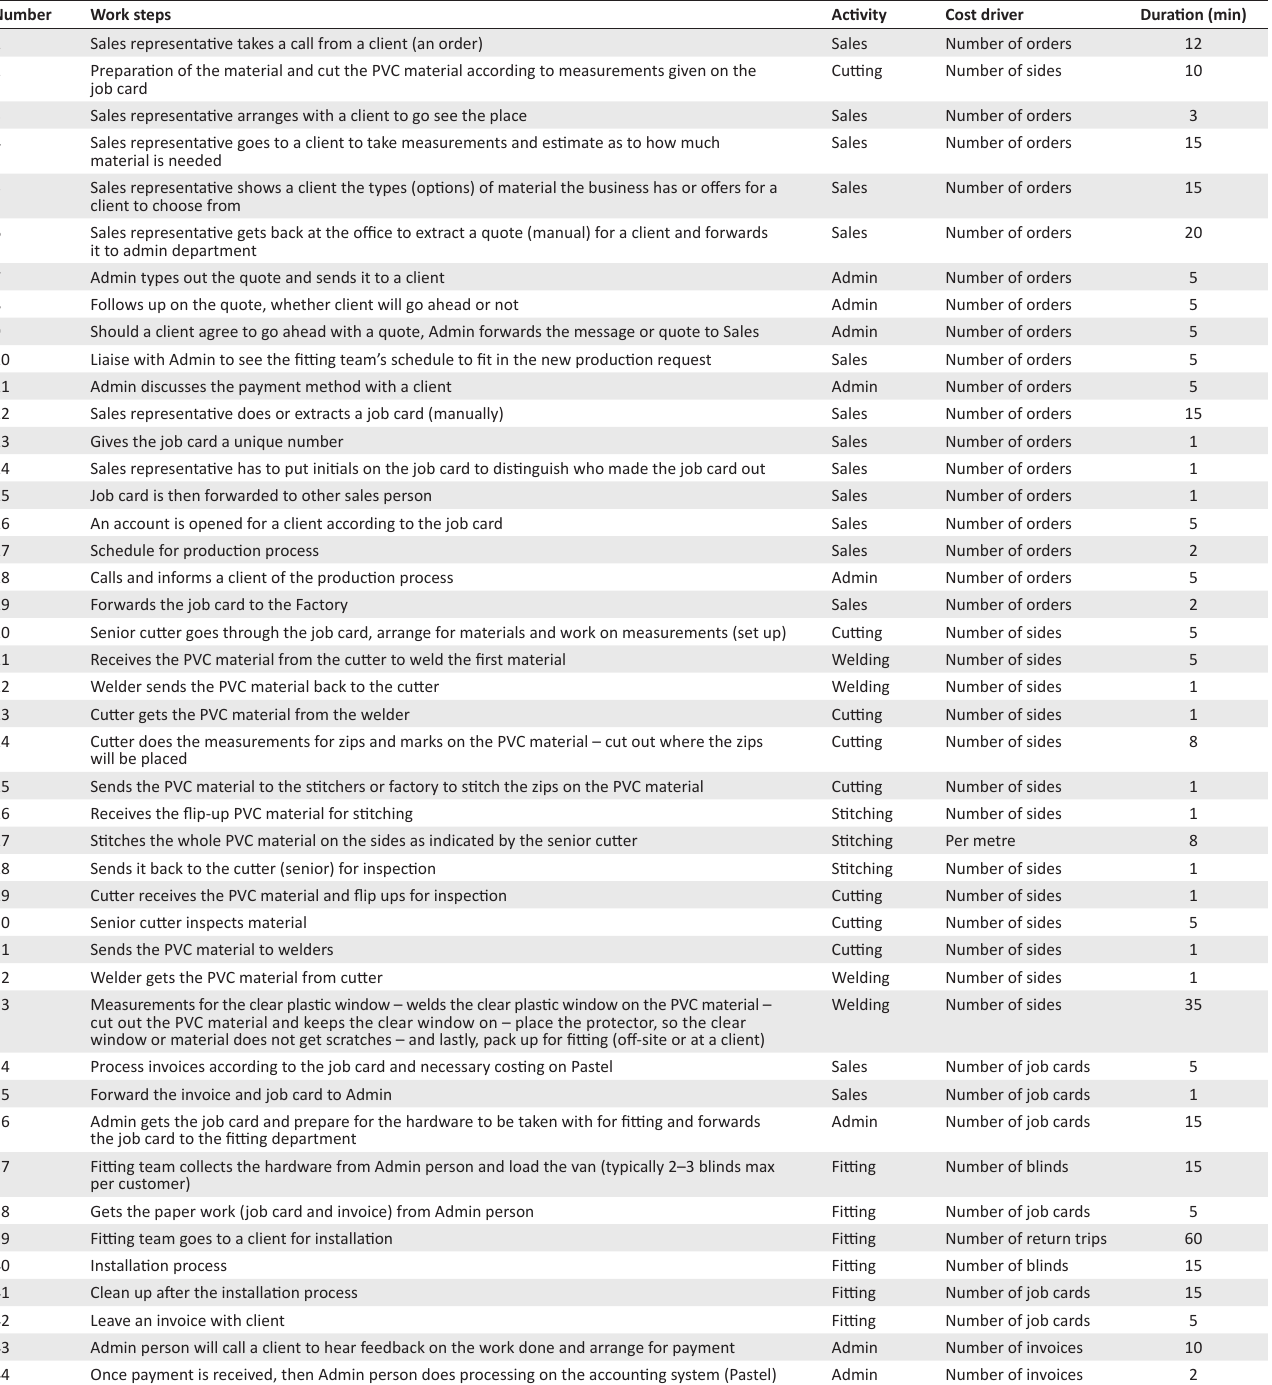
TABLE 1-A2: Work steps for polyvinyl chloride